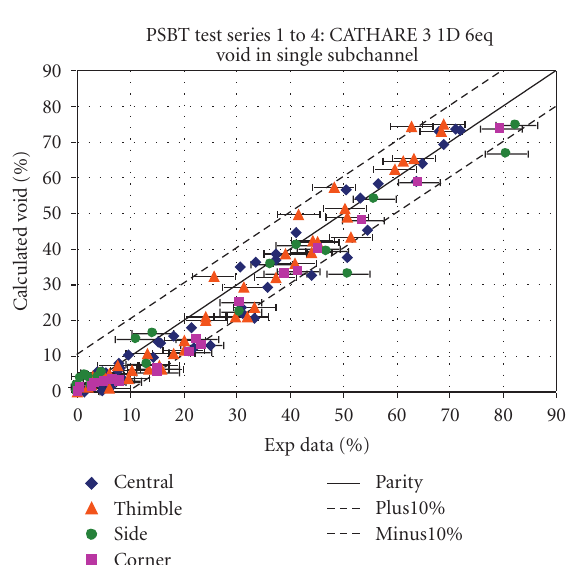
Figure 3: PSBT single subchannel test comparison: axial void profiles of 5 tests in a standard central subchannel.